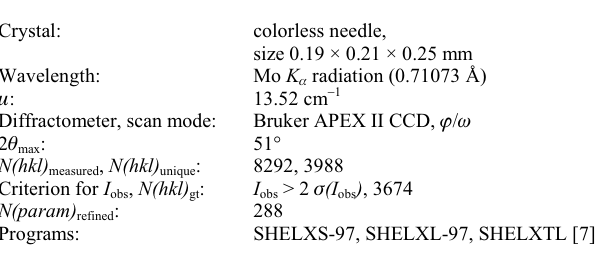
Table 1. Data collection and handling.